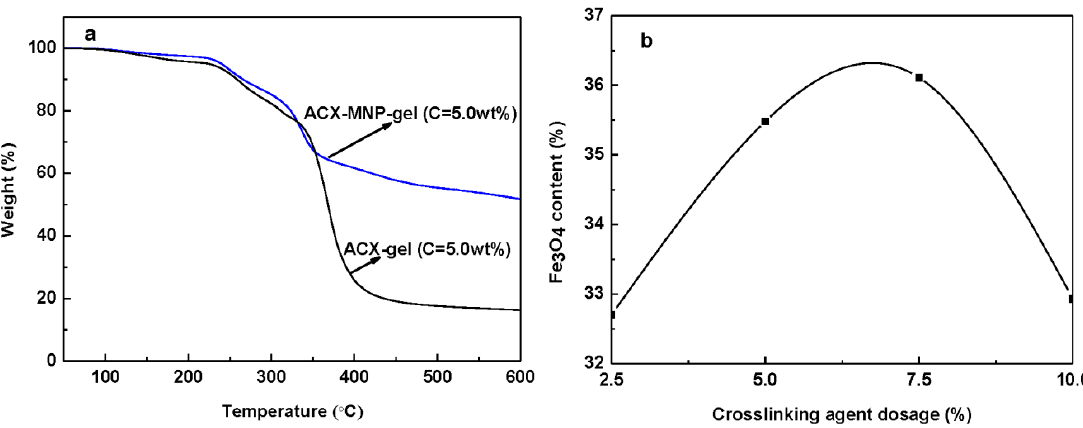
Figure 6. ( a ) Thermogravimetric curves of dehydrated hydrogels with C = 5.0 wt %; ( b ) The content curve of Fe 3 O 4 in ACX-MNP-gels with different crosslinking concentrations.